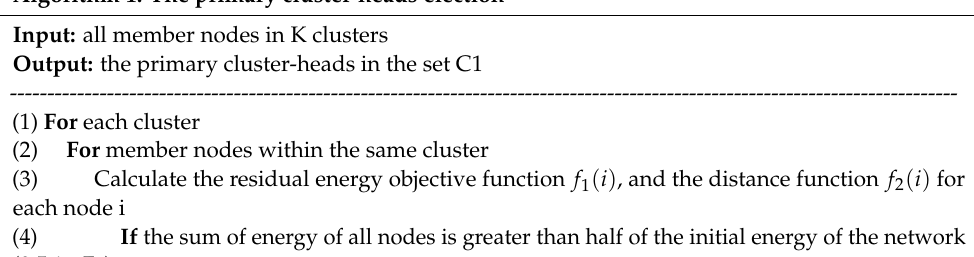
Algorithm 1 in DCK-LEACH for the primary cluster-heads election is as follows: Algorithm 1: The primary cluster-heads election